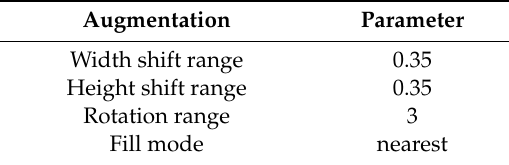
Table 2. Image augmentation parameters.